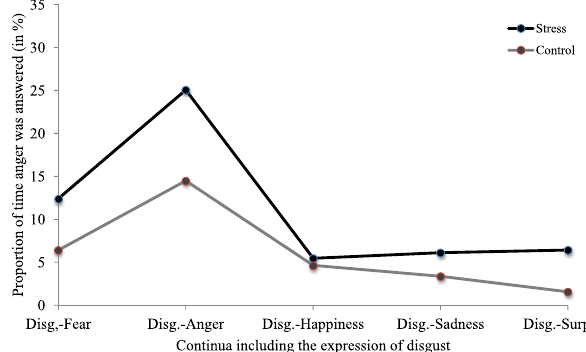
Figure 5. Proportion of time anger was answered when disgust was the dominant expression presented; for each combination of emotions including disgust and between experimental conditions.